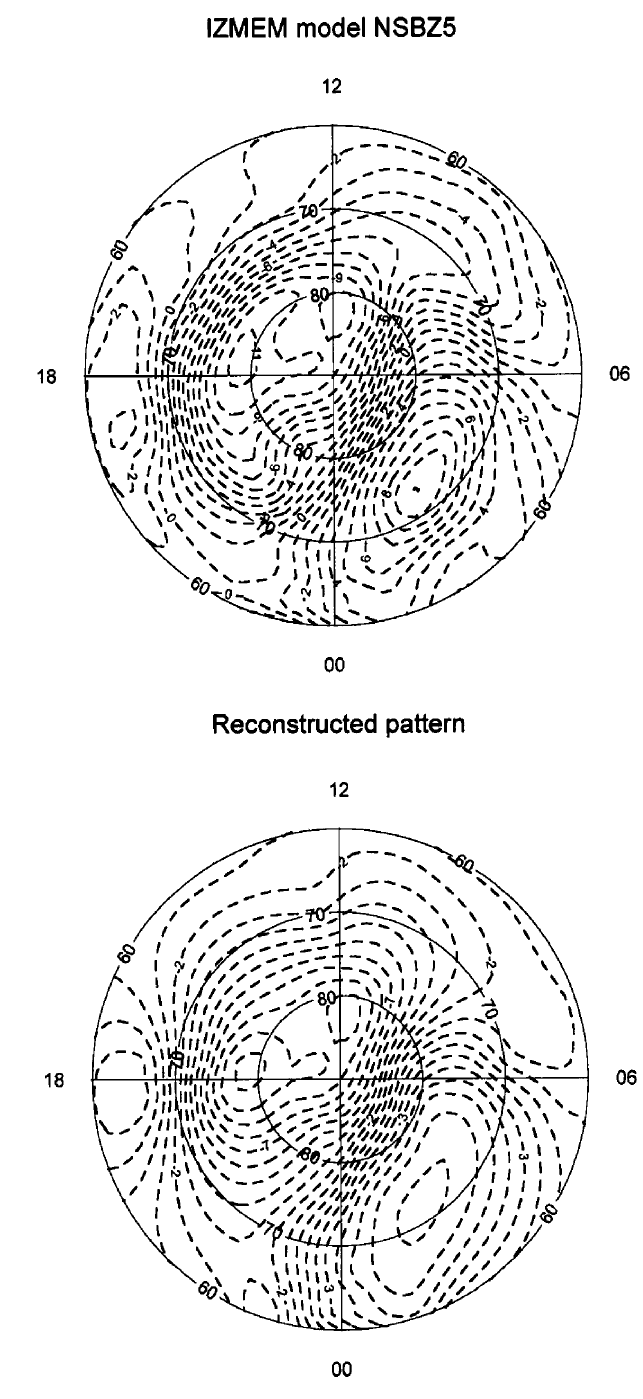
Fig. 5. Top distribution of the electric potentials in the northern summer polar cap for northward IMF ( B x (cid:136) 0, B y (cid:136) 0, B z (cid:136) 5 nT) obtained from the IZMEM/DMSP model. Bottom distribution of the electric potentials reconstructed by the electric field data along the noon-midnight and dawn–dusk MLT meridians using the stream